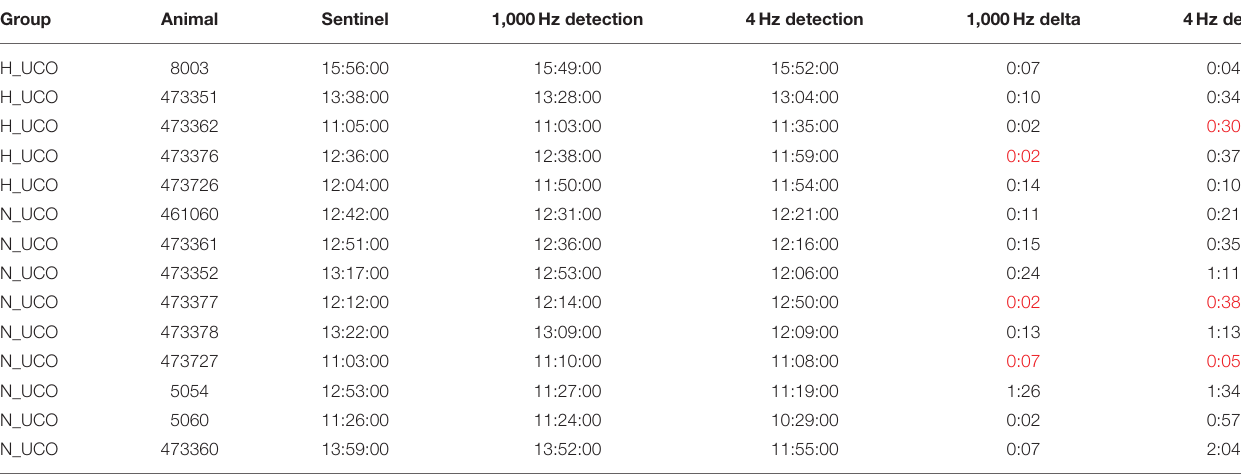
473360 Sentinel, time of detecting the onset of pathological ABP decreases during UCOs by an expert (visual analysis); 1,000 and 4Hz detection, times of detecting the same using the change point algorithm on RMSSD data derived from 1,000 or 4Hz sampled ECG; 1,000 delta and 4Hz delta, the time difference (sentinel-1,000 or sentinel-4Hz) between expert and change point algorithm detection performance: detection by the algorithm preceded in most cases the expert detection, median 8.5 (IQR = 10.5) minutes and median 36 (IQR = 44.3) minutes, respectively; Red font, cases when the algorithm detection happened after the expert detection; note that in the case of 4Hz delta, 2 out of 3 instances the detection was more than 30min too late compared to ∼ 3min too late in the three cases at 1,000